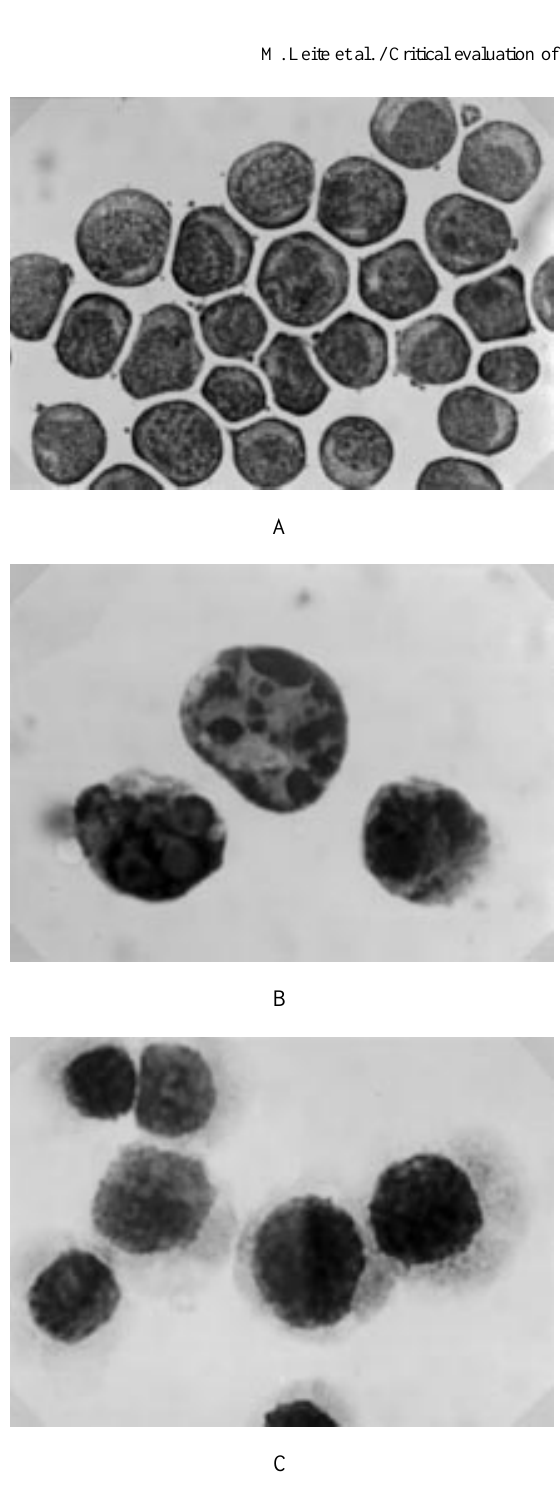
Fig. 1. Cytospins of HL60 cells stained with Giemsa showing morphological characteristics of: (A) unirradiated cells (control); (B) apoptotic cells after 15 sec of UV radiation and (C) necrotic cells after 1 h exposure to UV radiation. A, (cid:2) 400 magnification; B and C, (cid:2) 1000 magnification.